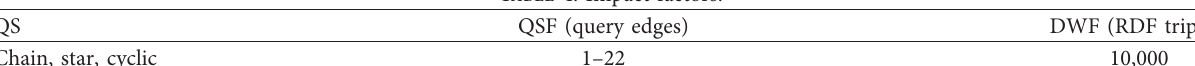
Figure 7: Different query shapes: (a) chain queries, (b) star queries, (c) cyclic queries, and (d) chain star queries. Table 4: Impact factors.